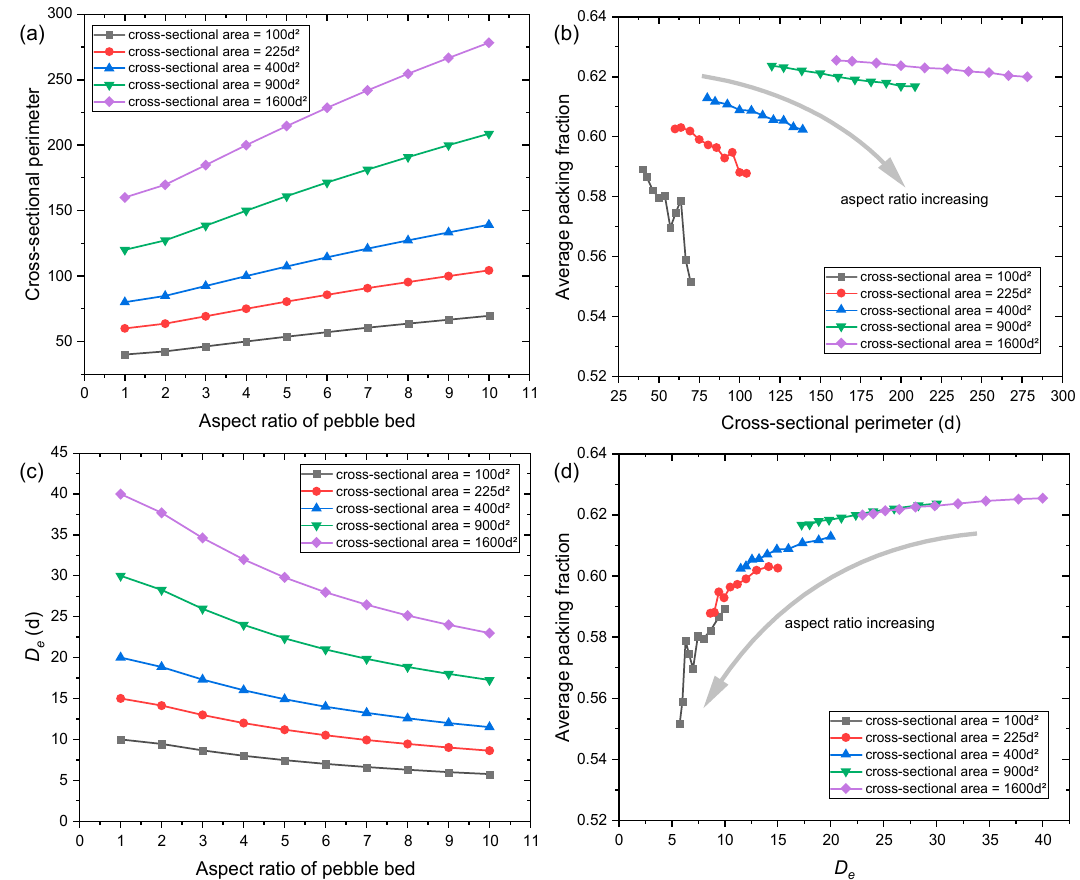
Figure 7. Average packing fraction of the rectangular packed pebble beds as a function of ( a , b ) the cross-sectional perimeter of the container; ( c , d ) the equivalent diameter of the container.